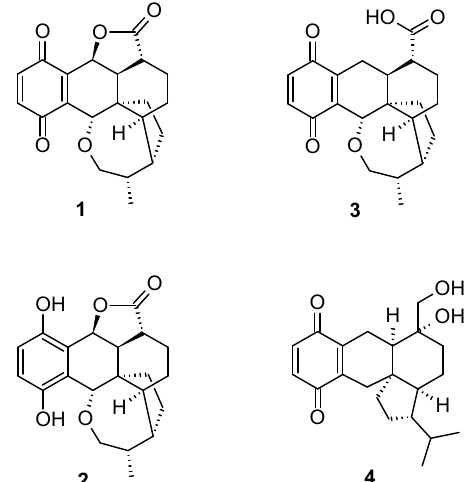
Figure 1. Chemical structures of previously isolated pleurotin derivatives: pleurotin ( 1 ), leucopleurotin ( 2 ), dihydropleurotinic acid ( 3 ) [5], and pleurogrisein ( 4 ) [13].